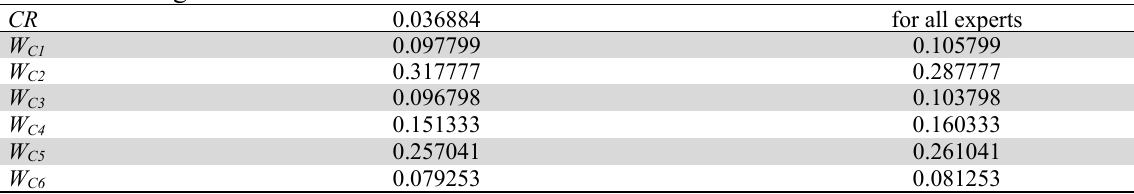
Deffuzified weights